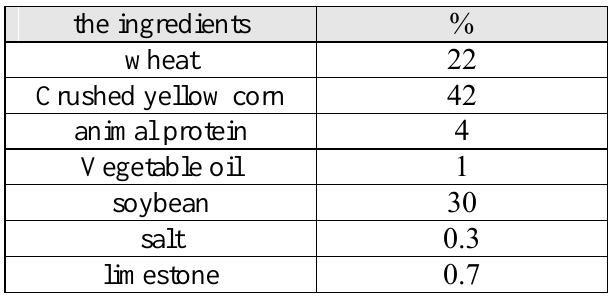
Table 1: The percentage of the components of the diet used in the Experiment